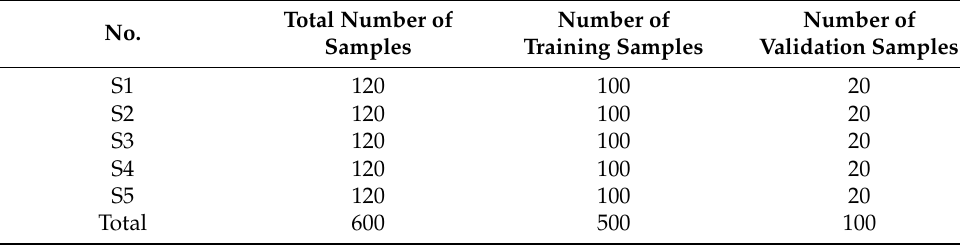
Table 2. The division of data set sample.